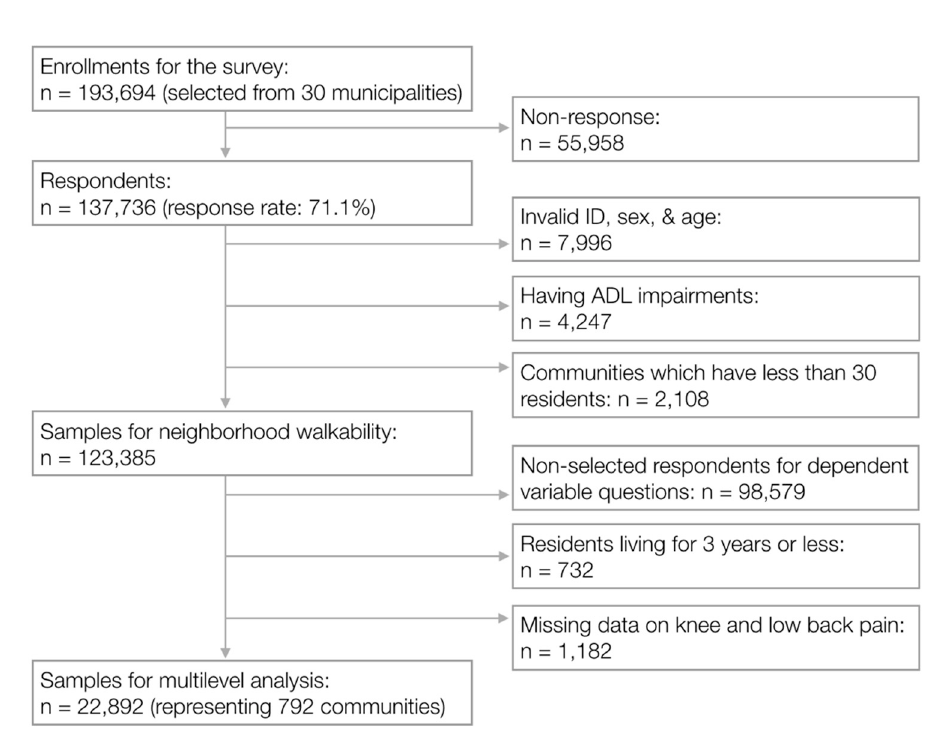
Figure 1. Flow of participant selection for the study of neighborhood walkability and musculoskeletal pain ( n = 22,892). ID, identification; ADL, activities of daily living.